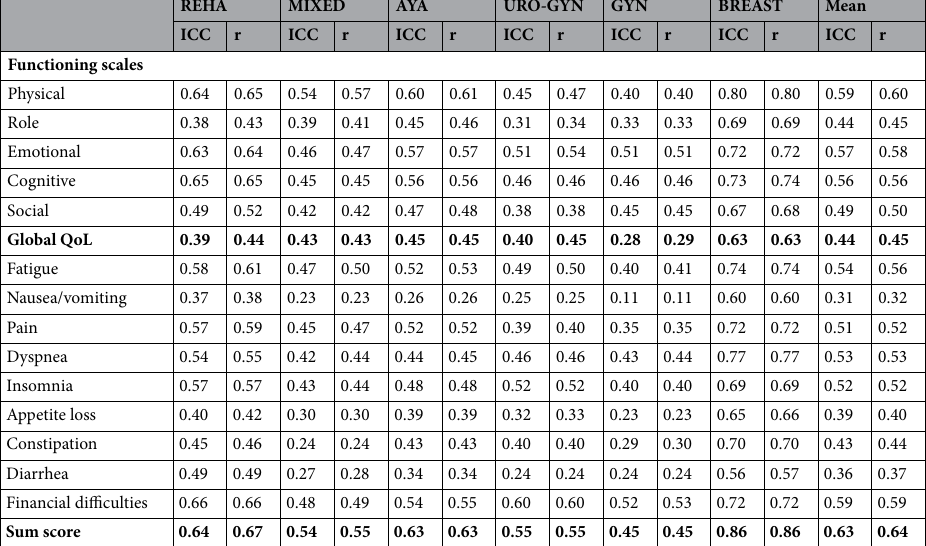
Table 2. ICCs and Pearson correlations for the total samples. Bold: global or summarizing scores. All of the 96 correlations of the six samples except one (GYN, nausea/vomiting; p < 0.05) are statistically significant with p <